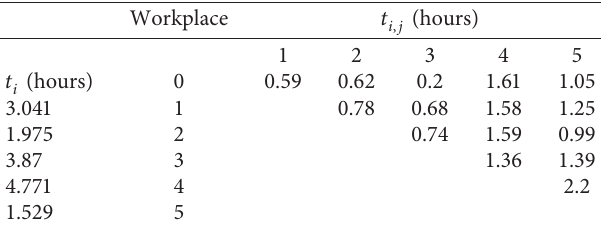
Table 4: An example of the generated random values for travelling and advising times.